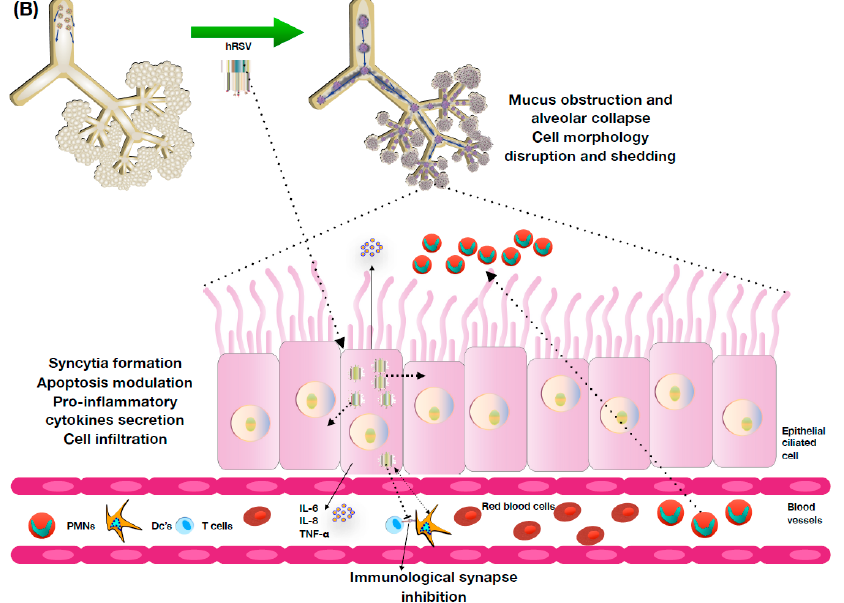
Figure 1. hRSV structure, pathology, and immune response.( A ) The hRSV is an enveloped virus with a non-segmented, negative-sense, and single-stranded RNA genome. It has a genome of 15.2 kb consisting of 10 genes that codifies for 11 proteins; ( B ) The main target of infection of this virus are the epithelial ciliated cells. Its lung pathology is associated with mucus obstruction of the airways and its consequent alveolar sparing. The immune response associated to this pathogen is characterized by infiltration of PMNs to the lungs (eosinophil, neutrophils, monocytes); inflammation of the distal bronchial airways; a weak and unresponsive T cell immunity, most-likely due to the inhibition of the proper assembly of the Immunological synapse; and the secretion of many pro-inflammatory cytokines, such as, IL-6, IL8, TNF-a, among others.